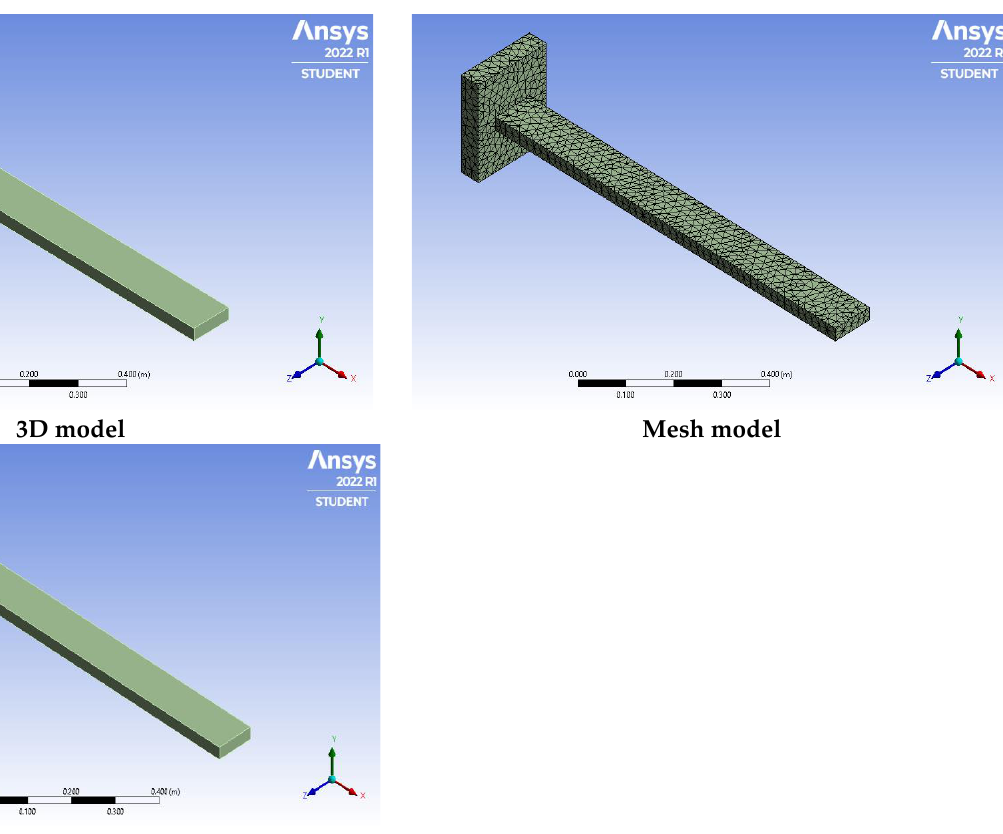
Figure 4. Defining analysis choices for cantilever prismatic beam.